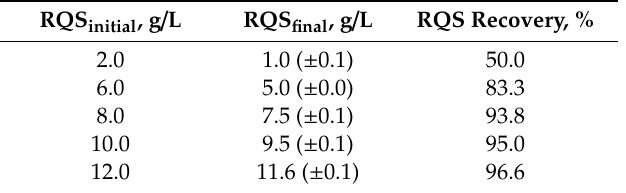
Table 4. Change of the concentration of red quinoa saponins (RQS) after enzymatic hydrolysis. RQS initial , g /